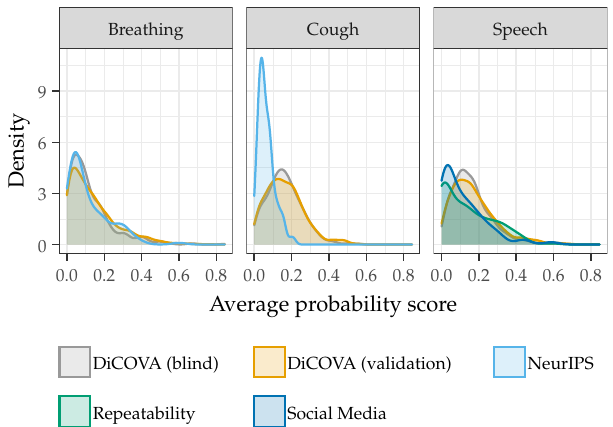
Figure 6. The distribution of average probability scores for all recordings in a particular